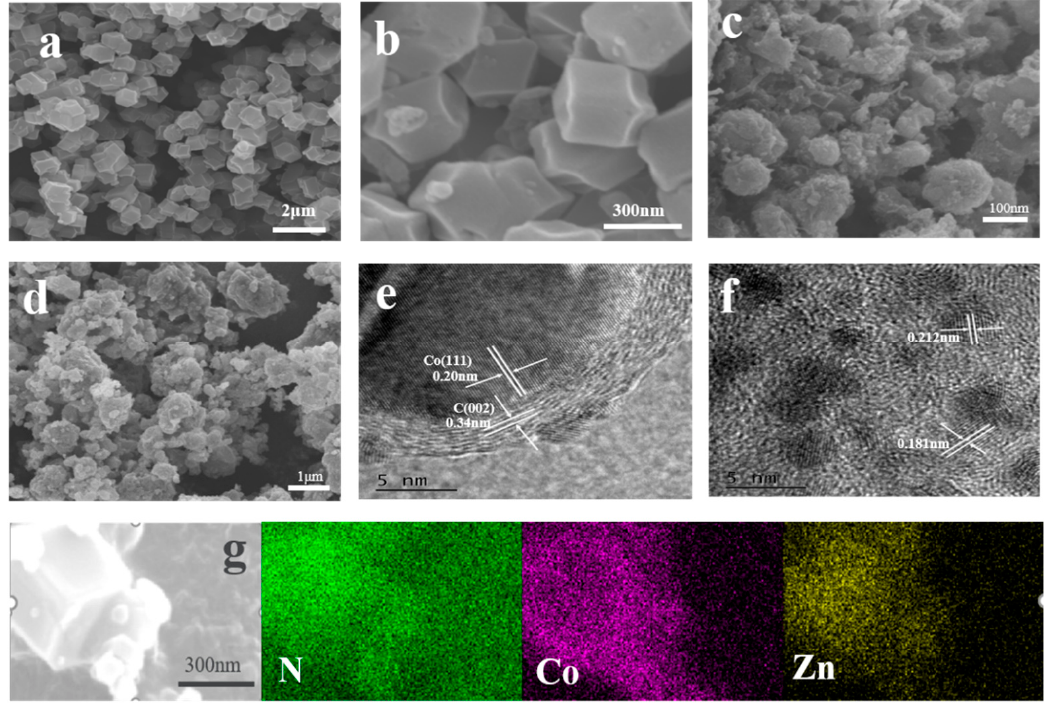
Figure 2. ( a ) SEM image of Co@ZIFs-1-6; ( b ) corresponding enlarged SEM image; ( c ) SEM image of MNC-1-6; ( d ) SEM image of PtNi/MNC-1-6; ( e , f ) TEM image of PtNi/MNC-1-6; ( g ) SEM image of